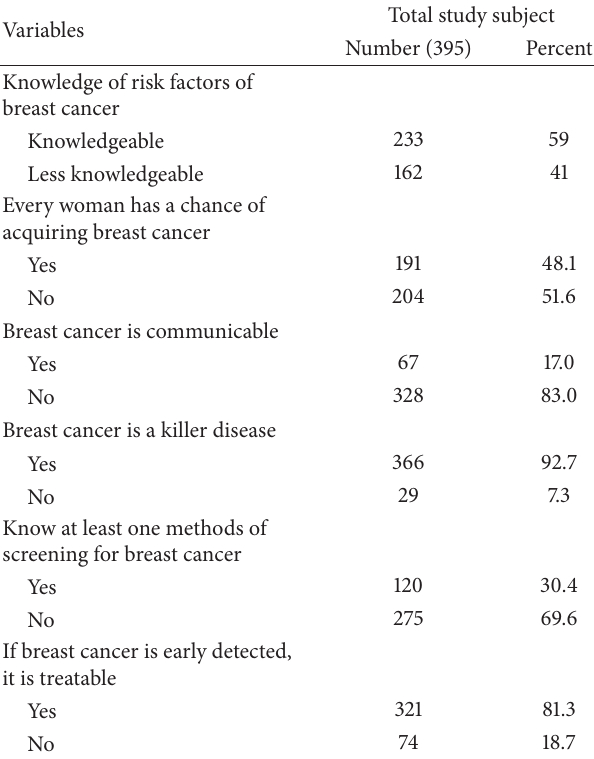
Table 2: Knowledge of HEWs on breast cancer in West Gojjam Zone, Northwest Ethiopia, October 2012.